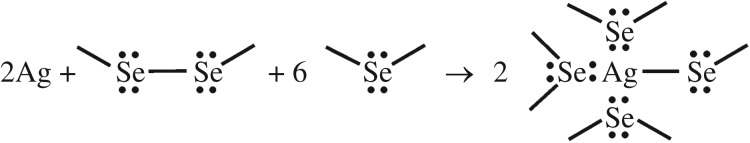
Schematic of a bonding scheme in which two Ag atoms break a single Se–Se homopolar bond to create two fourfold coordinated Ag atoms. Following the proposal of Kastner [68], each AgSe4 motif contains one covalent Ag–Se bond, formed by using the valence electron from Ag and a valence electron from one of the Se atoms of the initial homopolar bond, and three dative Ag–Se covalent bonds, formed by using the lone pair electrons (shown by dots) on three other Se atoms and the three empty s-p orbitals of the Ag atom.